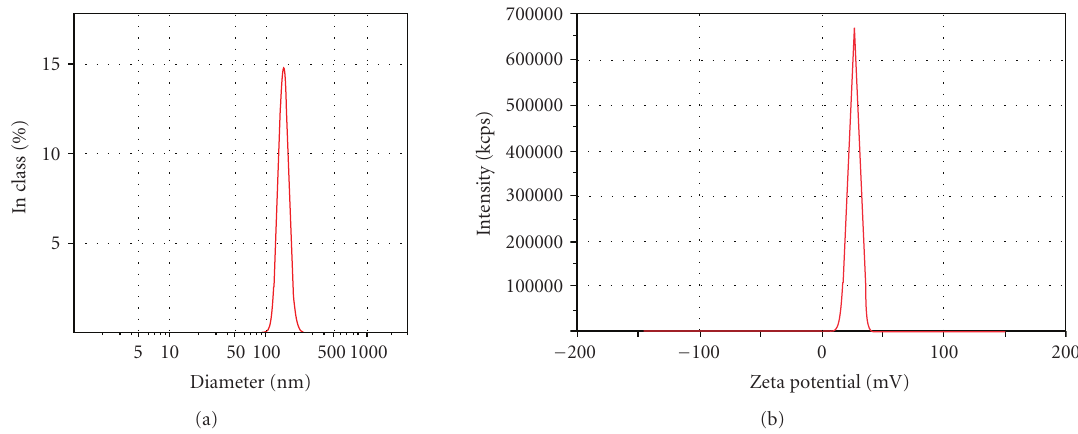
Figure 2: (a) Size distribution and (b) zeta potential of the prepared chitosan-coated PBCA-NPs.